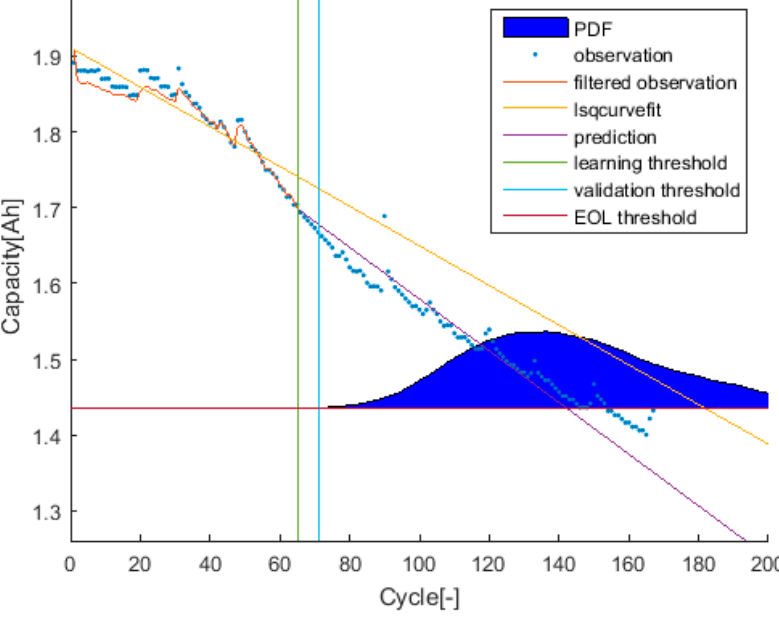
Figure 1. An example of the trial-instant figure with a training data set of 71 samples from which the last 6 samples compose the validation data set (the vertical green line represents the learning threshold, and the blue line represents the training threshold). The prior knowledge is composed by a linear model (yellow line) and data from the battery B0007 (blue dots). The time-instant of interest is defined by the EOL threshold (the horizontal red line), which is the capacity value at the 146 sample. The prediction probability density is displayed by the green area called PDF. The algorithm response on the learning data set is the orange line. The purple line represents the algorithm response on the rest of the data set.